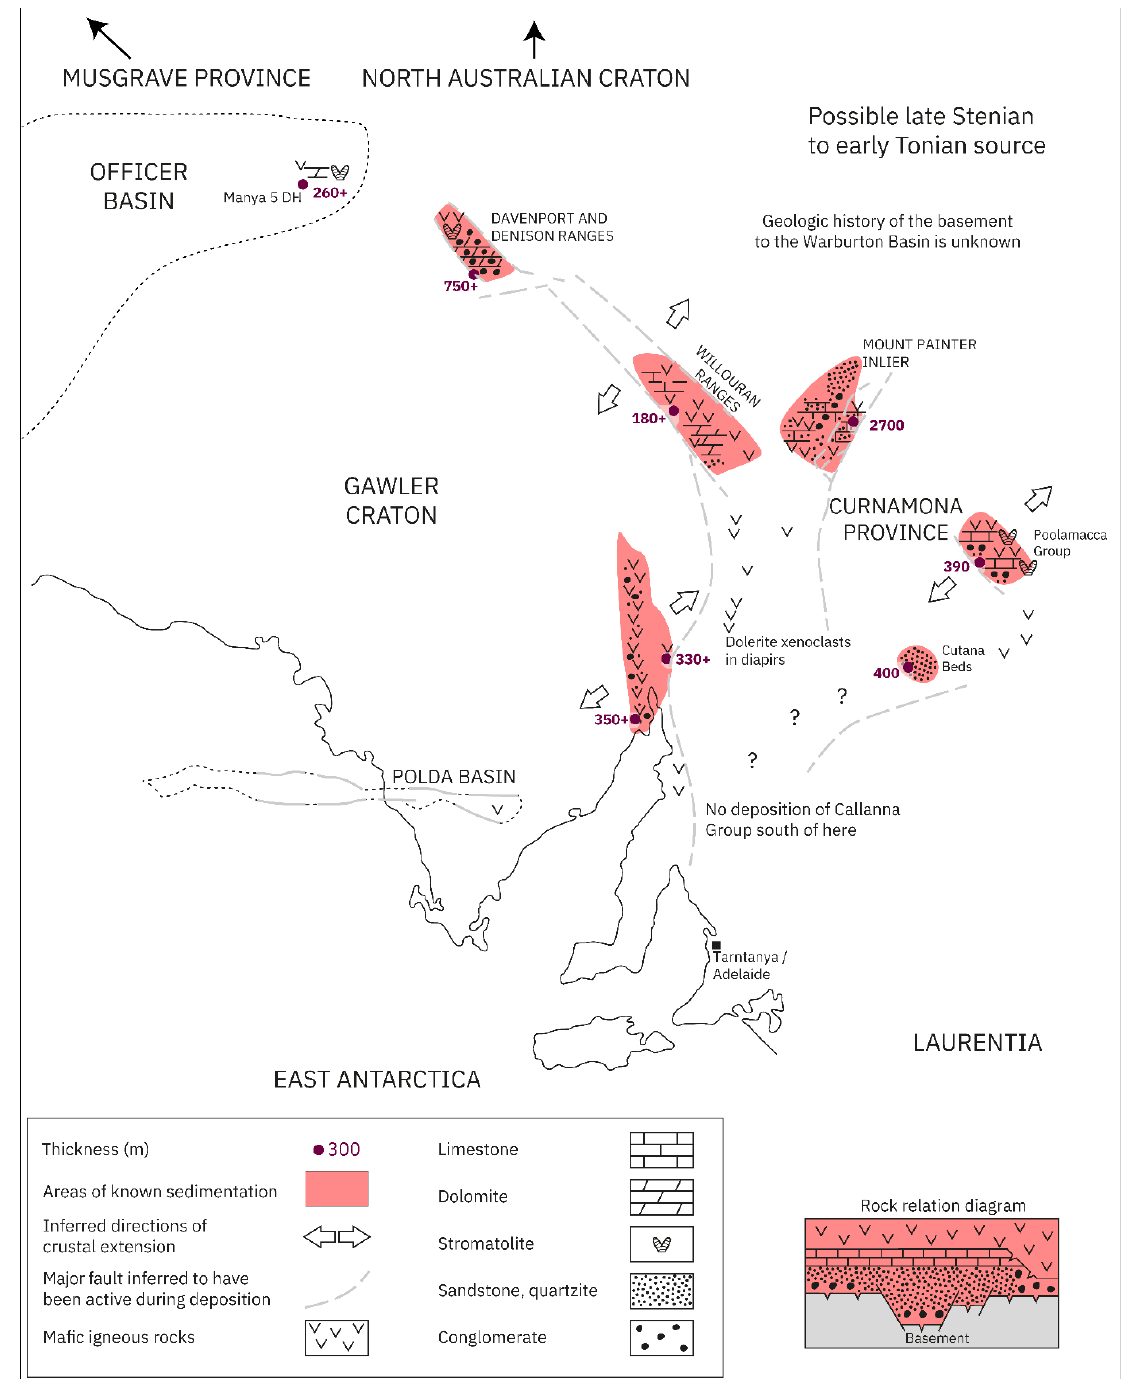
Figure 10. Paleogeographic map showing the known distribution of the Arkaroola Subgroup (c. 890–830 Ma) sedimentary deposition. Relative positions of relevant continental blocks in Rodinia are also indicated. Dolerite xenoclasts in diapiric breccia are likely related to the Gairdner Dyke Swarm of the Willouran LIP (see Figure 3). Deposition of Arkaroola Subgroup rocks may have occurred in regions between the indicated areas, However, this is not confirmed. Geography of the Adelaide Superbasin is shown in its modern-day configuration, with the modern coastline shown for reference. Adapted from Preiss [41].